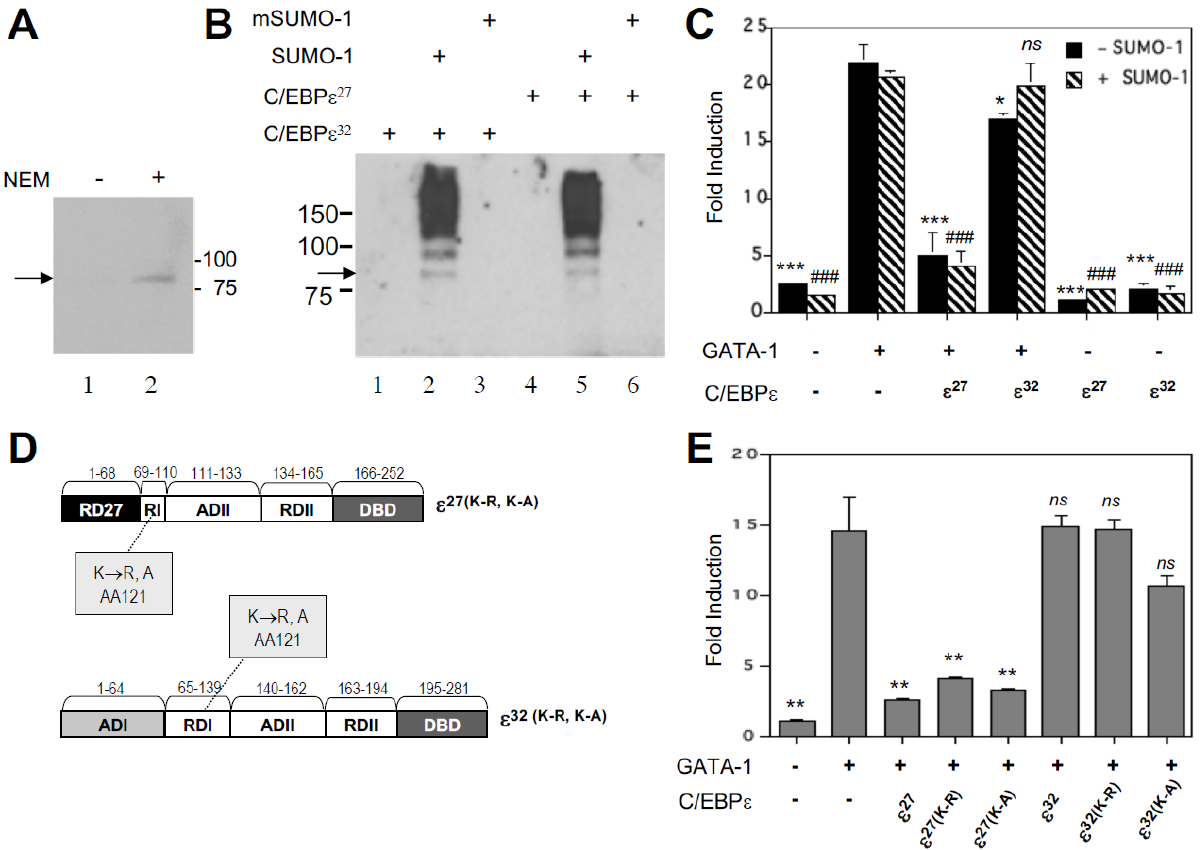
Figure 6. ( A , B ) C/EBP ε is sumoylated in the eosinophil lineage. Detection of endogenous sumoylated C/EBP ε in AML14.3D10 eosinophil lysates prepared in the presence of 50 μ M N -ethylmaleimide, immunoprecipitated with anti- C/EBP ε antibody, and detected by Western blotting using an anti-SUMO-1 antibody ( A ). Detection of sumoylated C/EBP ε 32 and C/EBP ε 27 in lysates of COS-7 cells transfected as indicated with expression vectors for C/EBP ε 27 , C/EBP ε 32 , FLAG-SUMO-1, and mutant-FLAG-SUMO-1 (a form of SUMO-1 in which the target glycine has been converted to alanine and is unavailable for conjugation) ( B ). Lysates prepared with 50 μ M N -ethylmaleimide were immunoprecipitated with anti-C/EBP ε antibody and the Western blot probed with anti-FLAG M2 HRP-conjugated antibody. ( C – E ) Over-expression of SUMO-1 or mutation of the C/EBP ε 27 sumoylation site has no effect on the repressor activity of C/EBP ε 27 for GATA-1 transactivation of the MBP1-P2 promoter. Co-transfection of a SUMO-1 expression vector with C/EBP ε 32 or C/EBP ε 27 , does not alter the repressor activity of C/EBP ε 27 for GATA-1 trans-activation of the MBP1-P2 promoter, nor convert C/EBP ε 32 into a repressor independently or for GATA-1 ( C ) (* p < 0.05, ***, ### p < 0.001, compared to GATA-1 alone, ± SUMO-1, respectively). Mutation of the sumoylation target lysine (K) residue in the conserved SUMO (VKEEP) consensus site to either arginine (K → R) or alanine (K → A) ( D ) does not alter the repressor activity of C/EBP ε 27 for GATA-1 transactivation of the MBP1-P2 promoter ( E ) (** p < 0.01; ns , not significant, compared to GATA-1 alone). Mutation of this target lysine in full length C/EBP ε 32 ( D ) does not convert it into an activator or repressor in the presence of GATA-1 ( E